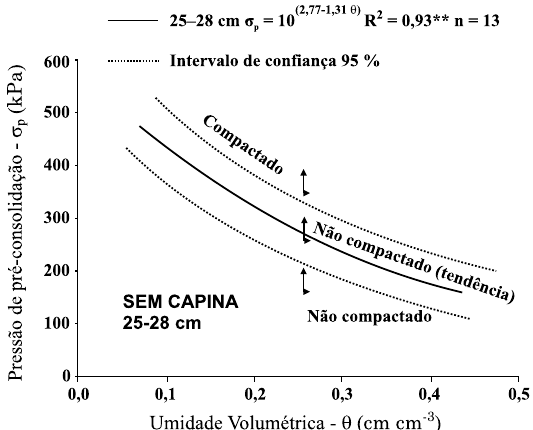
Figura 3. Modelo de capacidade de suporte de carga do Latossolo Vermelho-Amarelo da profundida- de de 25–28 cm, com os critérios sugeridos por Dias Junior et al. (2005), para quantificar a compactação causada pelos manejos de planta invasoras sobre a estrutura do